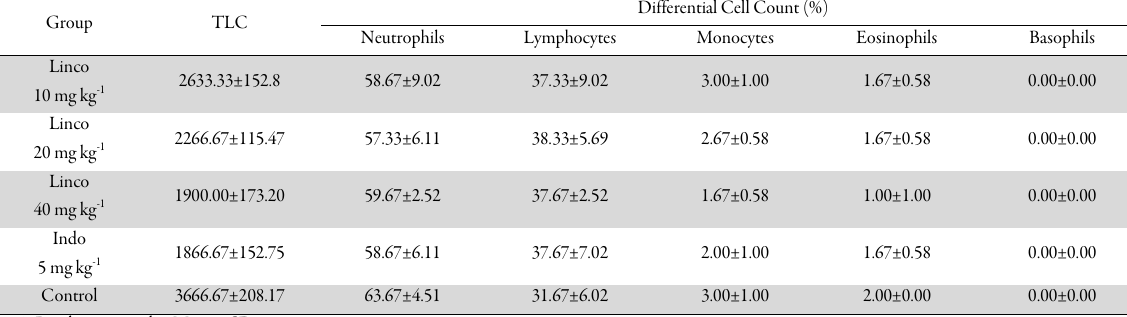
Table 2. Effect of Lincomycin on agar-induced leukocyte mobilization